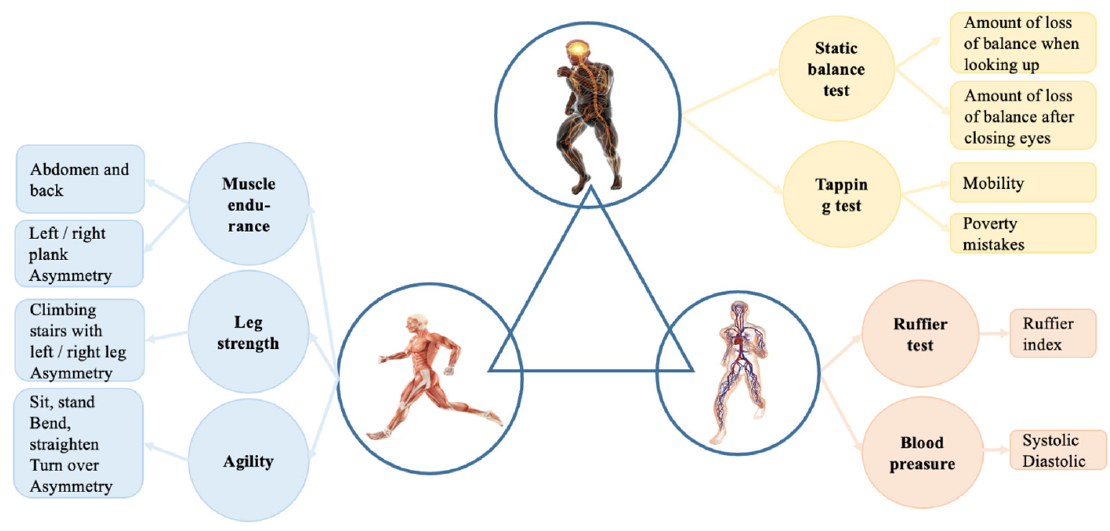
Figure 1. Three-part human body system and exercises that represent each part. The statistics of different parameters are presented in Table 1, where average values and standard deviations are shown. Different features have various metrics that lead to